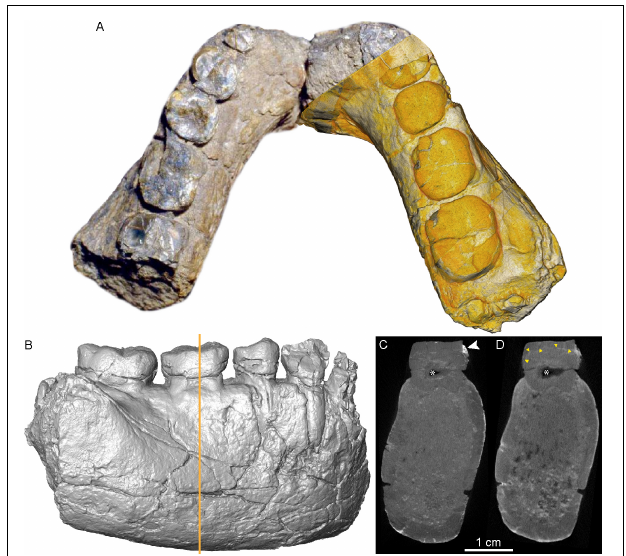
FIGURE 4 | Photomontage of the UR 501 hominin mandible, with the n- µ CT-based 3D rendering virtually superimposed over the right portion (A) . The X- µ CT-based rendering of the same portion in buccal view is shown in (B) . The coronal virtual sections through the corpus [orange line in (B) ] were respectively, extracted from the X- µ CT (C) and the n- µ CT (D) records. The white arrow in (C) highlights a denser area that absorbed more X-rays, creating a local saturation overflow that overwhelms the rest of the contrast range, thus reducing contrasts between enamel and dentine. The yellow arrow heads in (D) indicate the enamel-dentine boundary, not visible in (C) . The asterisks in (C) and (D) show differences in imaging of the pulp chamber, which is partially infilled with sediment (nearly transparent in the neutron